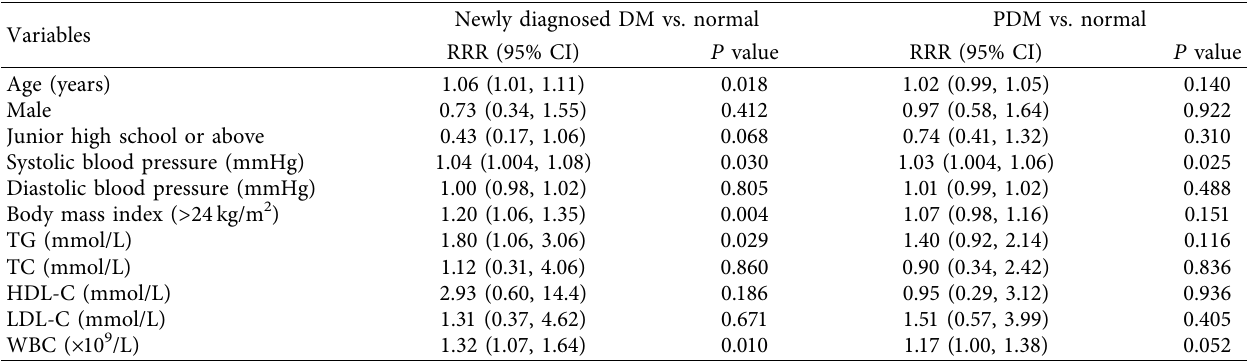
Table 5: Baseline multiple multinomial logistic regression analysis of risk factors for diabetes and prediabetes compared to the nondiabetes group in study